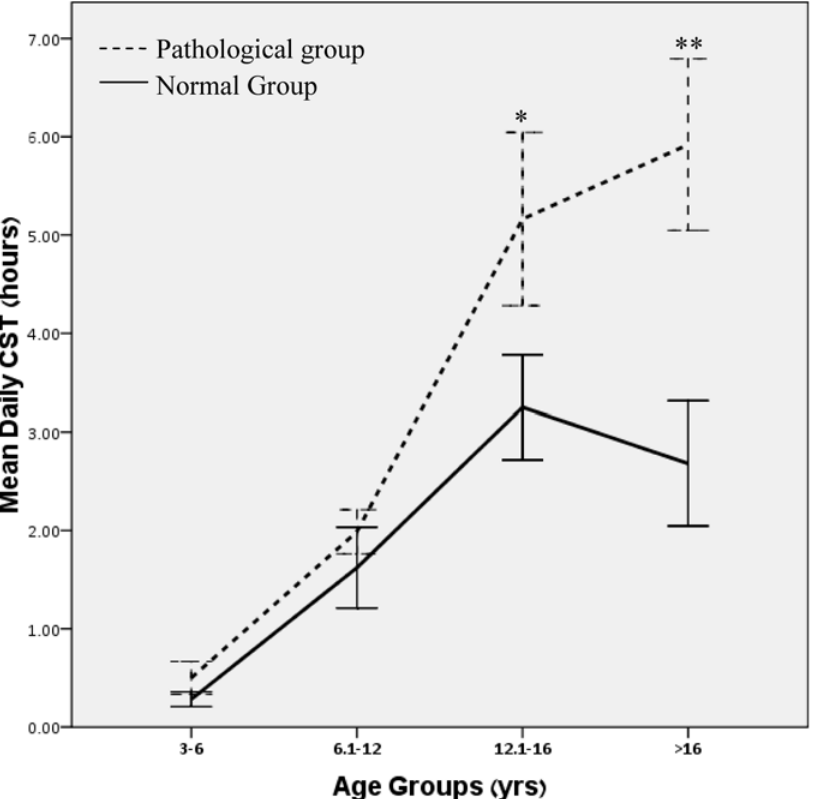
Fig 2. Mean daily computer screen time (hours) of the normal and psychopathology groups, at different developmental stages. * Borderline significant difference; ** Significant difference; Error bars represent ± 1 standard error. CST – Computer Screen